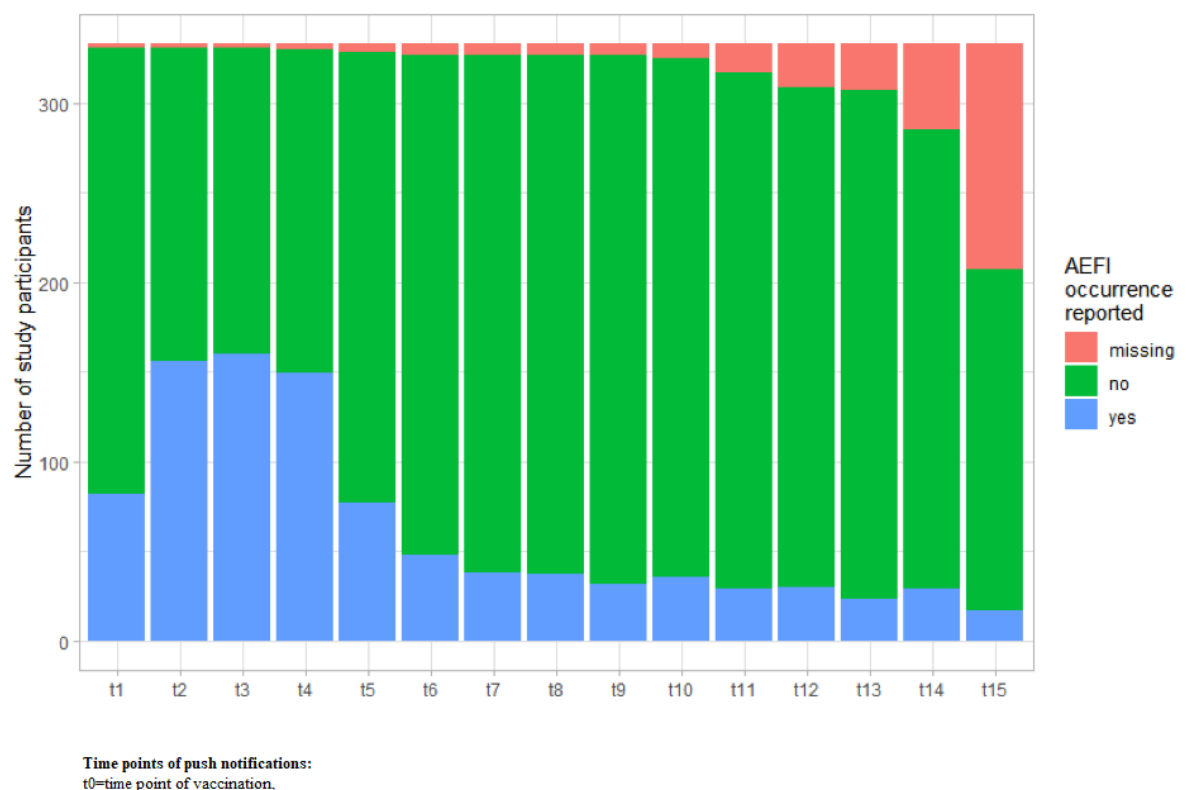
Figure 3. Reported adverse event following immunization occurrences per time point after influenza